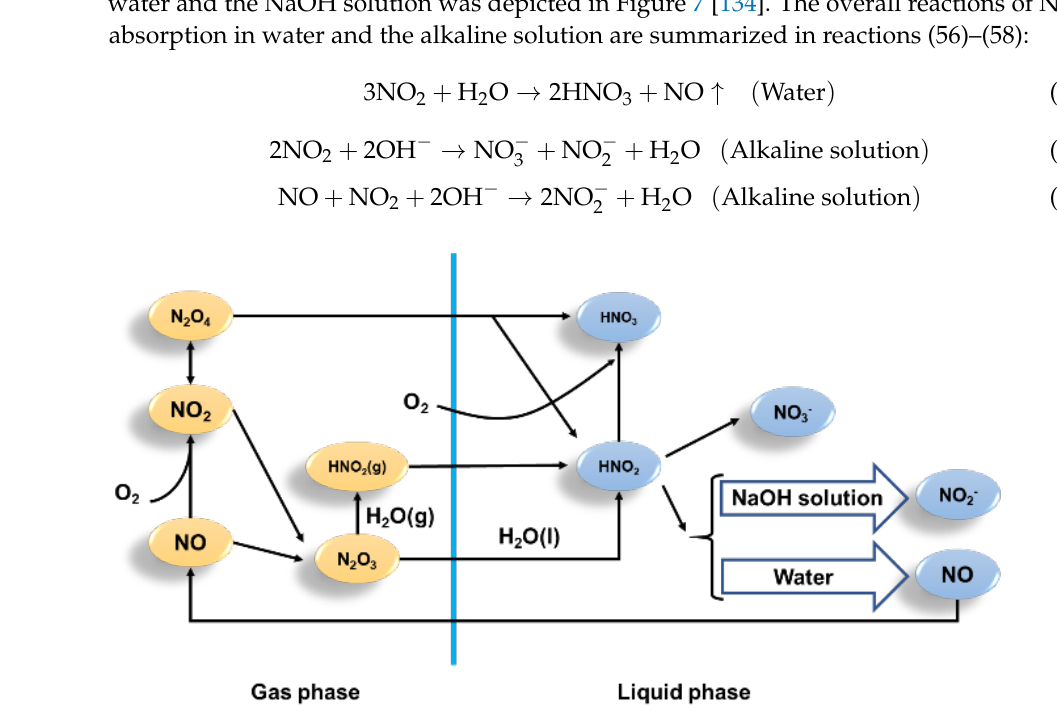
Figure 7. Scheme of NOx absorption into water and NaOH solution.